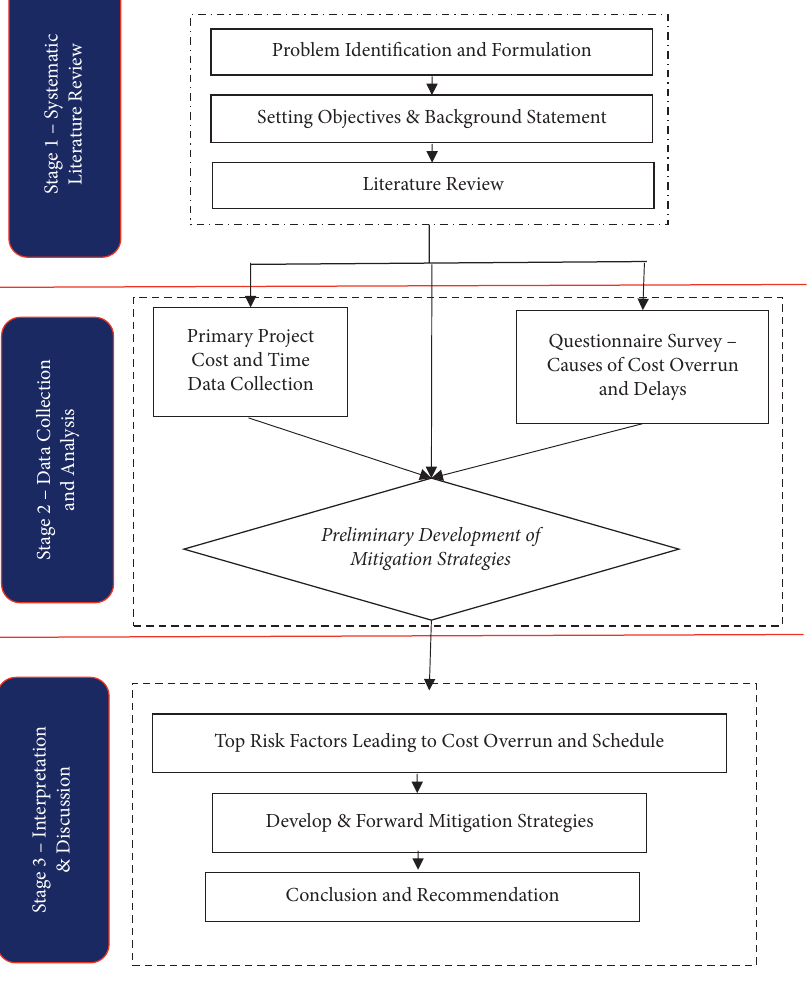
Figure 1: Research methodology